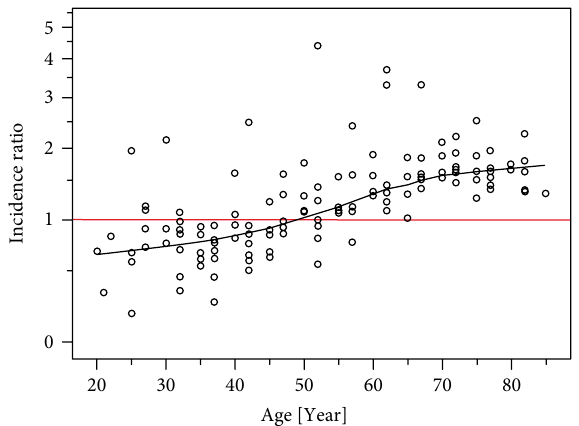
Figure 1: Male to female ratio of BCC incidence rates as a function of age. Each point represents ratio determination from paired data, i.e., for the same age period within each study. The best fit Loess line is shown (with Epanikov kernel at 50%). It crosses with the RR = 1 line of equal incidence rates of males and females (red line) at the age between 45 and 50 years.